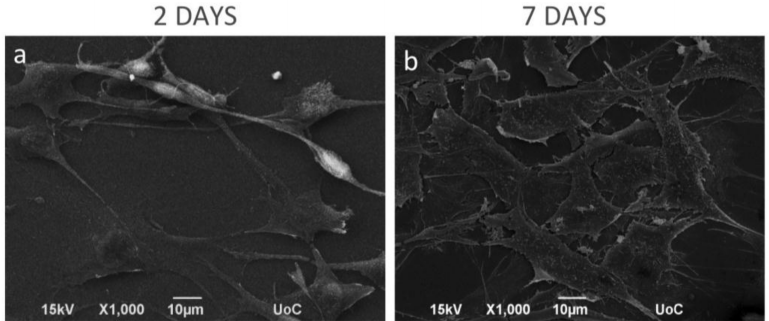
Figure 3. Scanning electron microscopy (SEM) images showing the morphology of MC3T3-E1 pre-osteoblastic cells on the CS- g -PCL surfaces, 2 and 7 days after seeding. SEM images illustrating MC3T3-E1 cell adhesion and growth on the copolymer surface: ( a ) After 2 days of seeding, a few cells were grown on the material surface, but they retain their elongated-fibroblastic morphology; ( b ) On day 7, cells have extensively proliferated forming a thick layer on the whole polymer surface. Original magnifications are 1000 × and scale bars represent 10 µ m.